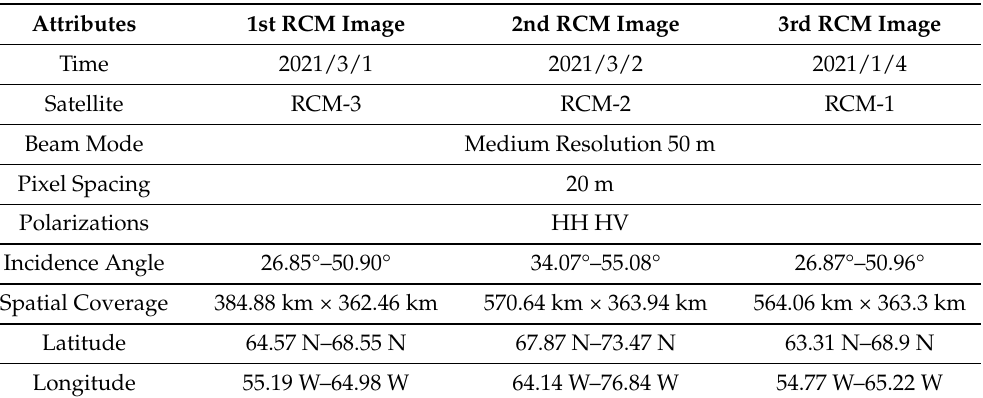
Table 2. Characteristics of RCM imagery used in this